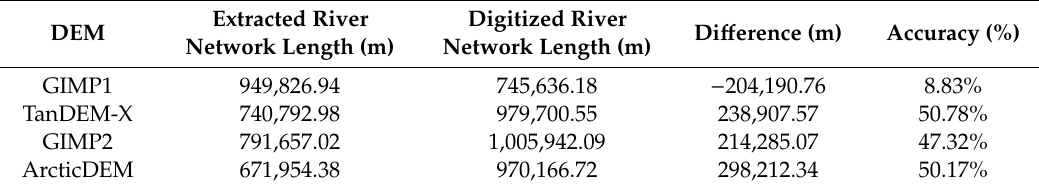
Table 10. Quantitative results of the river network extraction for three DEMs.